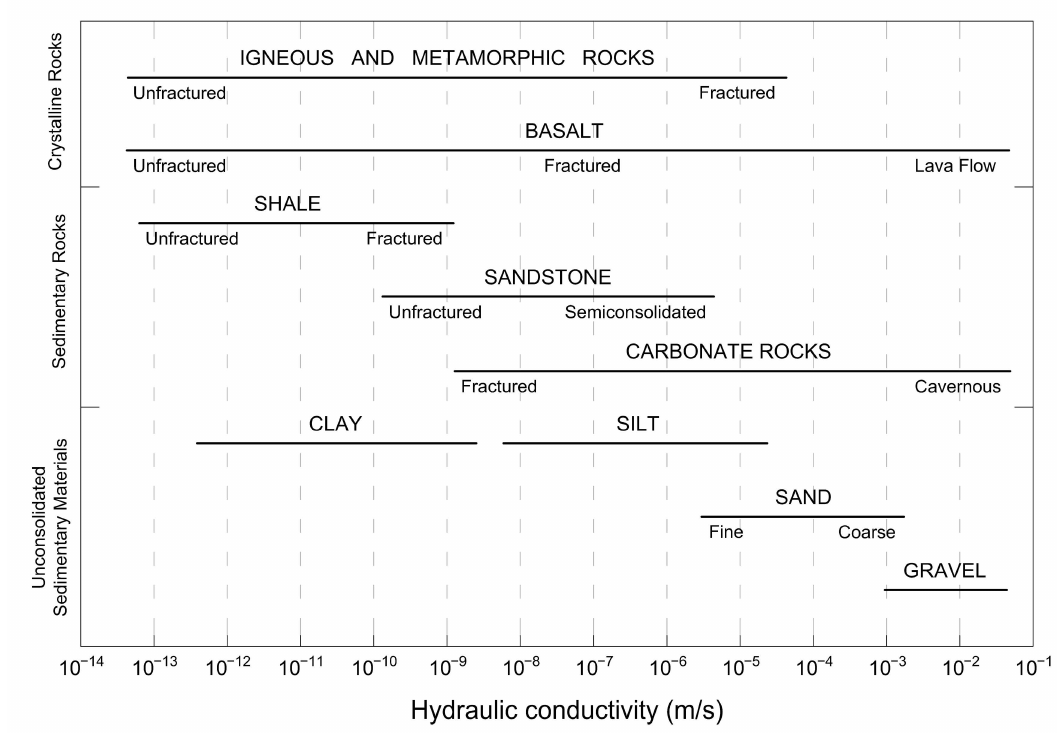
Figure 1. Hydraulic conductivity of selected consolidated and unconsolidated geologic materials (from